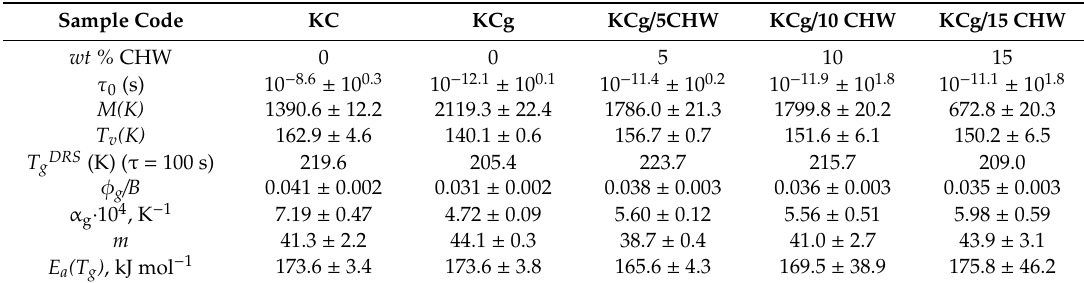
Table 1. Sample code and weight fraction (%) of chitin nanowhiskers (CHW) content and Vogel-Fulcher-Tammann-Hesse (VFTH) fit parameters, glass transition temperature evaluated from DRS analysis ( τ = 100s), relative free volume ( φ g / B ), expansion coe ffi cient ( α g ), fragility index ( m ) and activation energy ( E a (T g ) ) associated with the glass-rubber relaxation at T g of KC and KCg / x CHW samples ( x = 0, 5,10 and